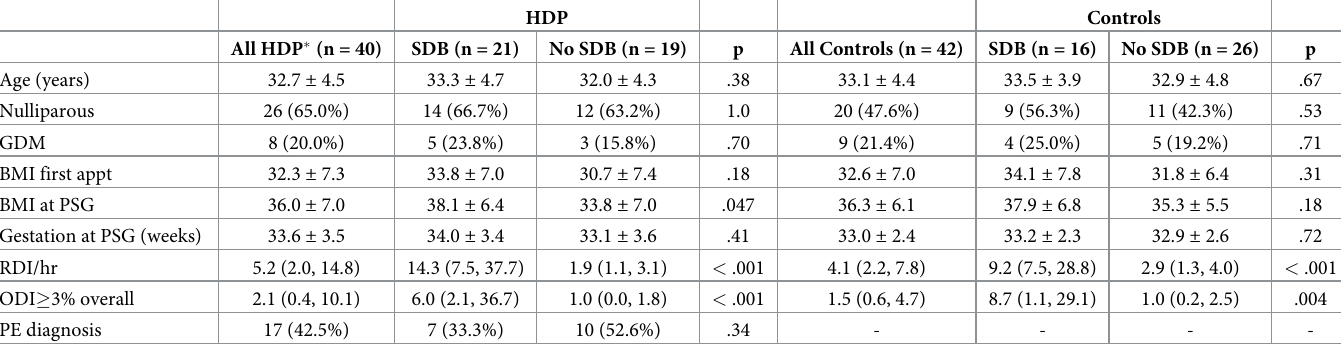
Table 1. Demographics for hypertensive disorders of pregnancy cases and normotensive controls stratified by SDB status. HDP